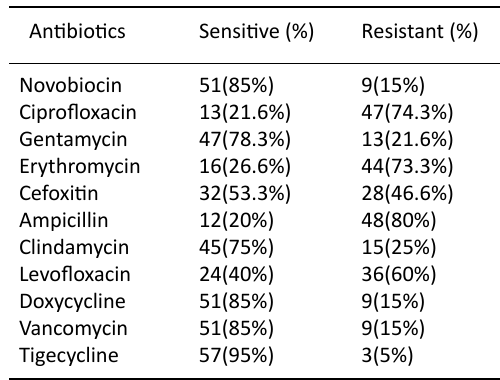
against CONS (n=60)